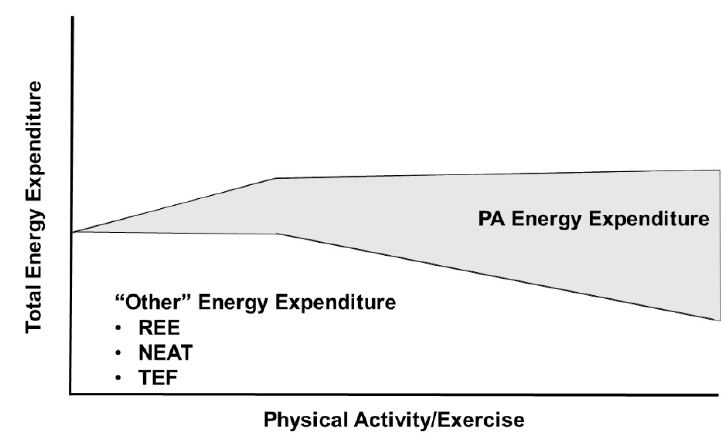
Figure 2. The Constrained Total Energy Expenditure Model suggests that total daily energy expenditure is maintained within a narrow range at high levels of physical activity energy expenditure by reducing other components of energy expenditure. Adapted from Pontzer et al. [21].